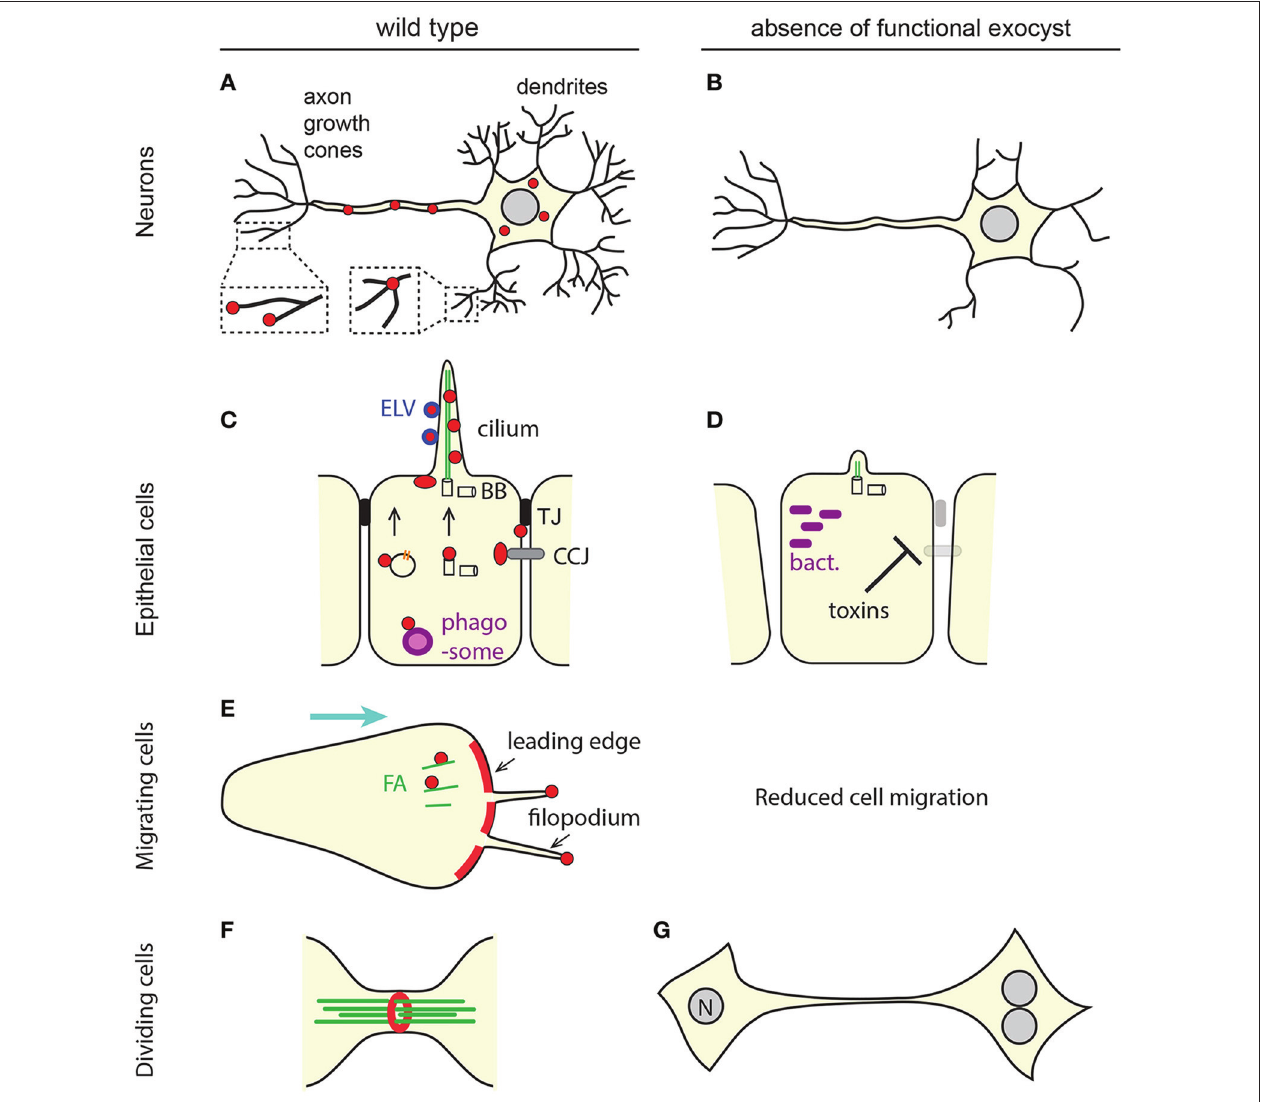
FIGURE 3 | Some of the multiple roles of the animal exocyst complex. (A,C,E,F) Overall localization of the exocyst in physiological conditions (red). For simplicity, the differential localization of individual sub-units is not represented here. The exocyst is mostly present at zones of bulk (leading edge, E ), or “finger-like” (neurites, A ; cilia, C ; filopodia, E ) membrane extension. (A) In neurons, some subunits accumulate at dentritic branching points, but not at growing tips of dendrites, whereas others localize to the tip of axon filopodia. (C,E) The exocyst localizes at sites of cell-cell or cell-matrix junctions (tight junctions, TJ, black; cell-cell junctions, CCJ, gray; focal adhesions, FA, green). It was also reported to be associated with trafficking vesicles carrying cell surface receptors (orange), with the migrating basal body (BB), with phagosomes or phagosome-fusing endosomes (purple) and with extra-cellular exosome-like vesicles (ELV, blue). (F) The exocyst can organize as a ring. (B,D,G) Cellular phenotypes associates with a loss of exocyst function. Protrusions necessary for cell function or migration are not formed, cell polarity and tissue integrity are compromised, phagosome acidification is altered which constitutes a window of opportunity for pathogenic bacteria, cells fail to complete cytokinesis, and undergo extra mitoses (nucleus, N). (D) Some toxins secreted by bacteria impair the delivery of the exocyst at cell junctions. See text for details and